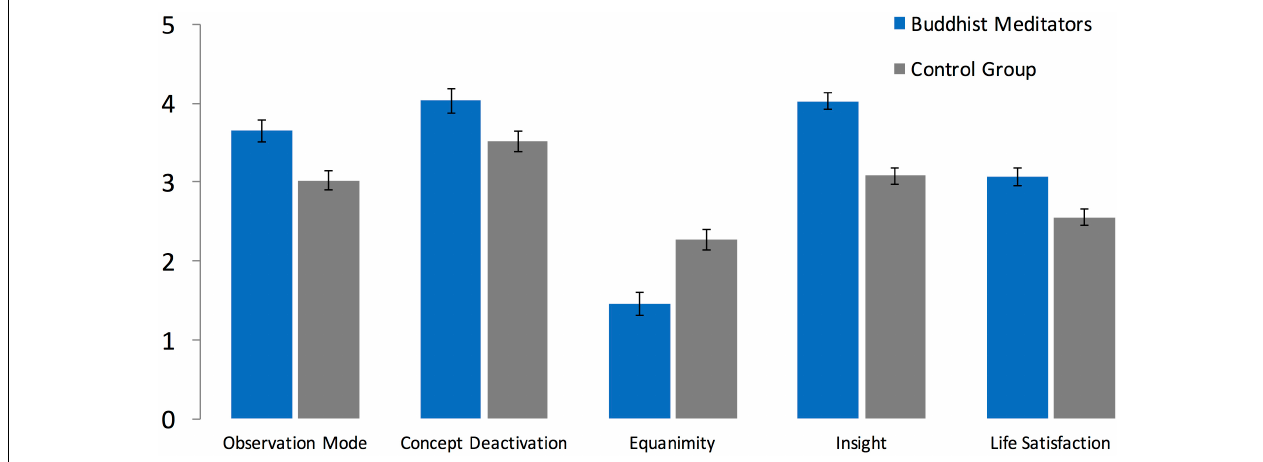
FIGURE 2 | Means and 95%-CIs of five outcome variables for Buddhist meditators ( N = 102) compared to a non-meditating control group ( N = 152). Because equanimity is measured by the intensity of emotions lower values represent higher equanimity.